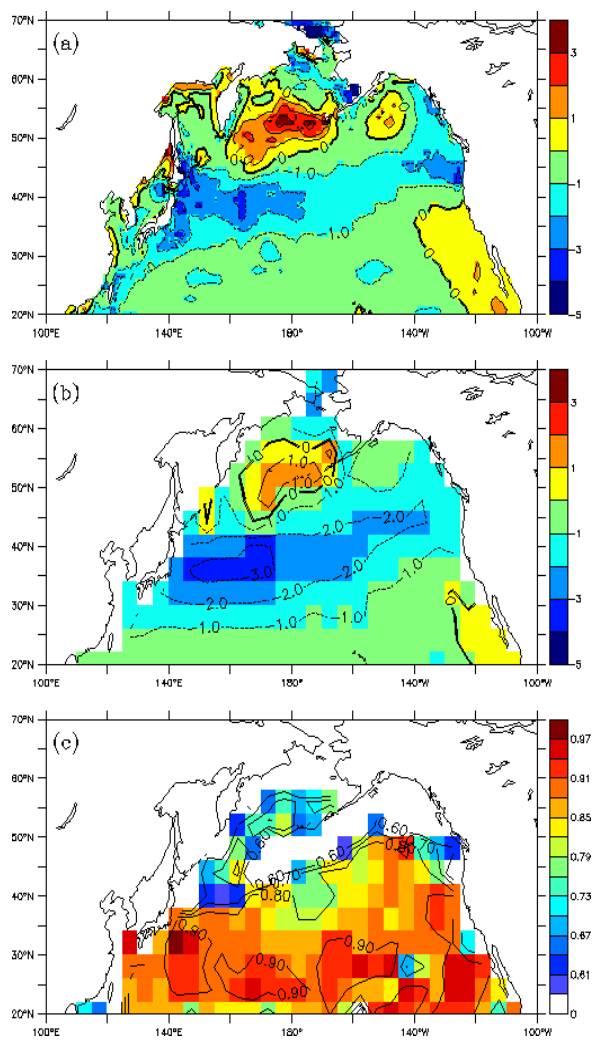
Fig. 2. Annual mean net air-to-sea CO 2 flux (negative represents CO 2 flux from atmosphere to ocean and vice versa) from the North Pacific from (a) the assimilation and (b) Takahashi et al. (2009). Units are in molm − 2 yr − 1 . (c) Seasonal correlation coefficients between assimilation and Takahashi et al. (2009) are shown only for those correlations above the 5% level.